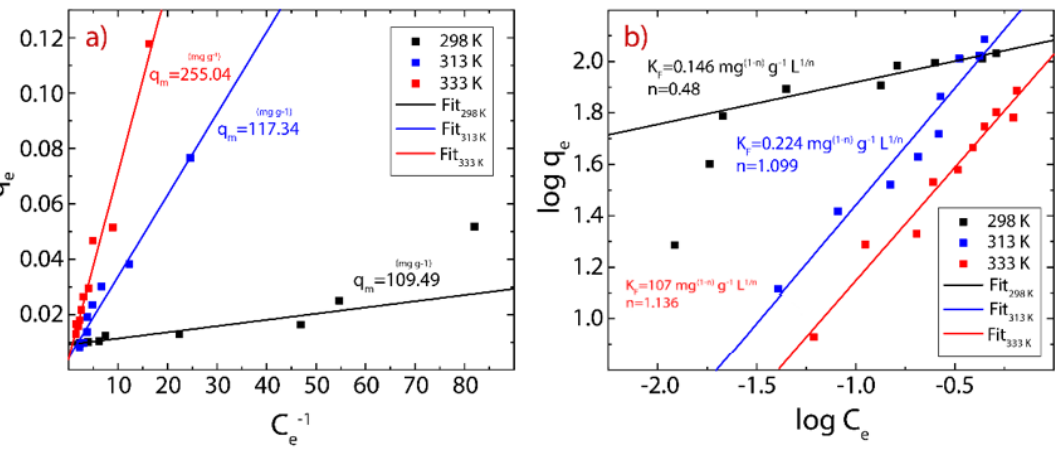
Figure 8. Adsorption isotherm of Hg(II) on rGO considering three different temperatures (289–333 K). ( a ) Langmuir model and ( b ) Freundlich model. Table 3. Parameters of the Langmuir and Freundlich models for the adsorption isotherms of MB onto rGO considering three different temperatures. T (K)